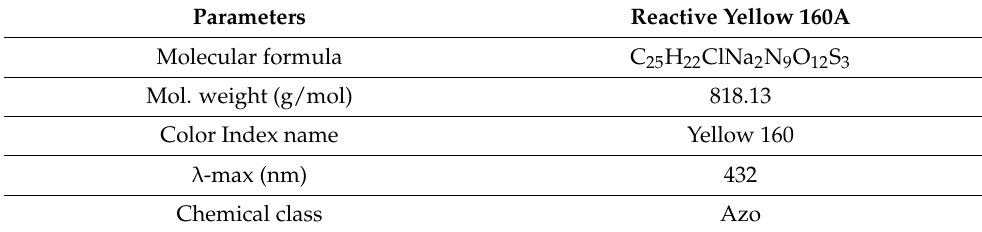
Figure 1. Chemical structure of Reactive Yellow 160A. Table 1. Reactive Yellow 160A specifications.